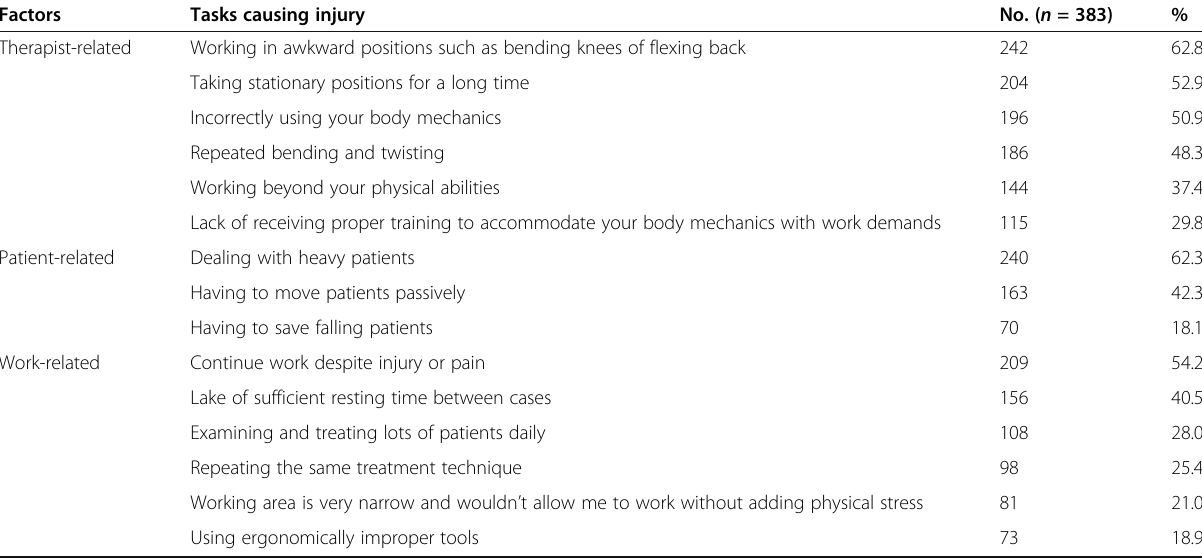
Table 3 Potential risk factors for